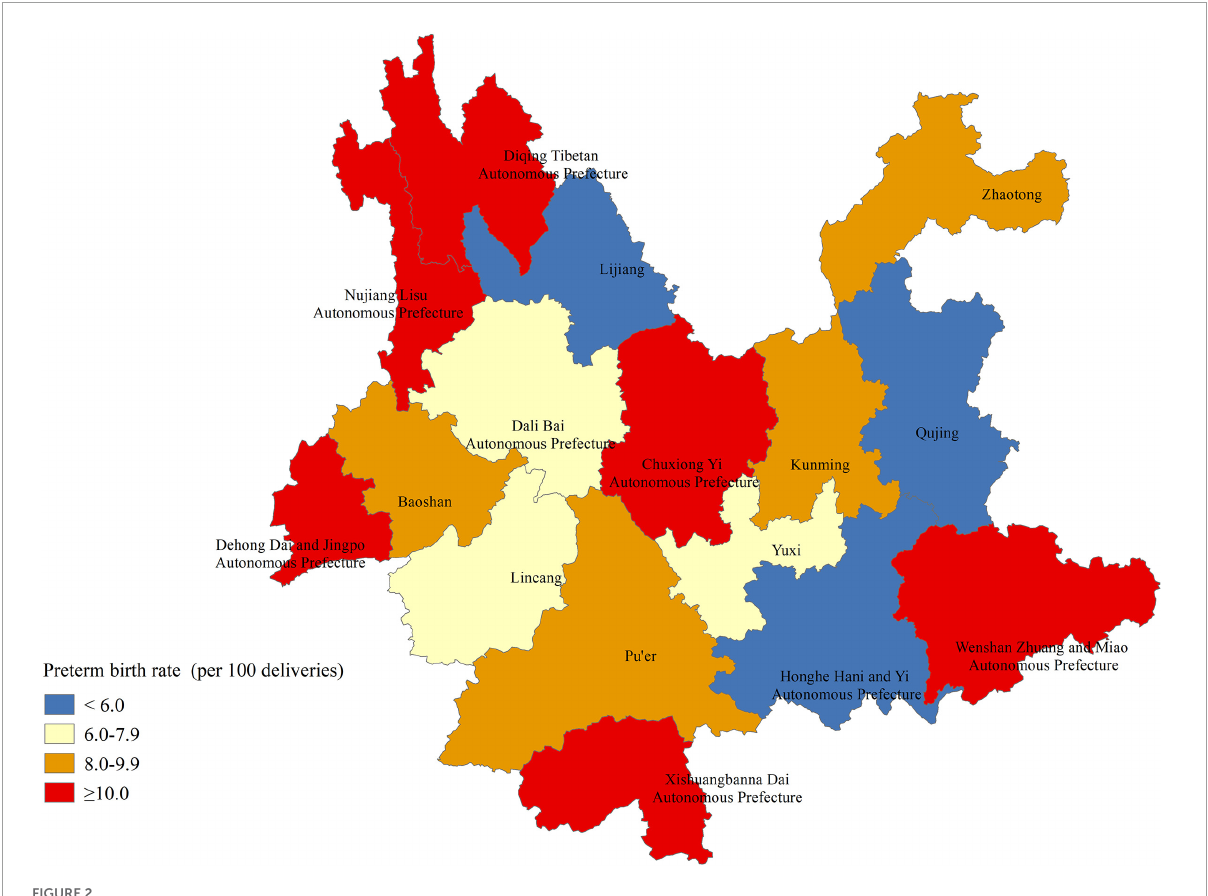
FIGURE2 Geographic disparities in the rates of preterm birth in rural Yunnan, Southwest China, 2014–2018.